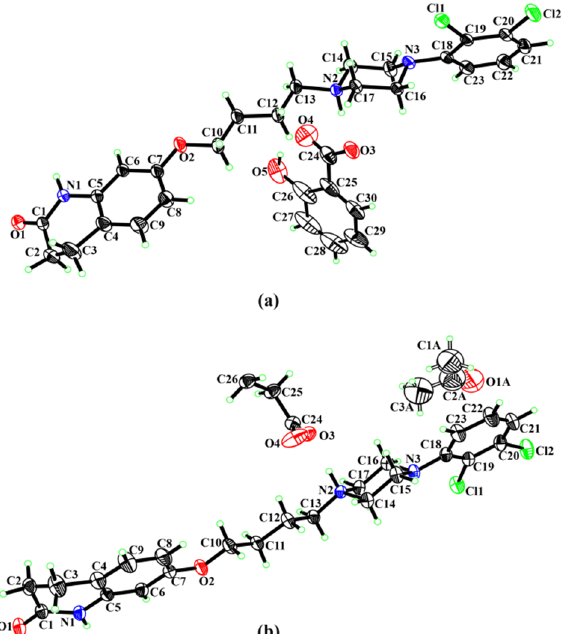
types of helices propagated along the b axis (Figure 2c,d).